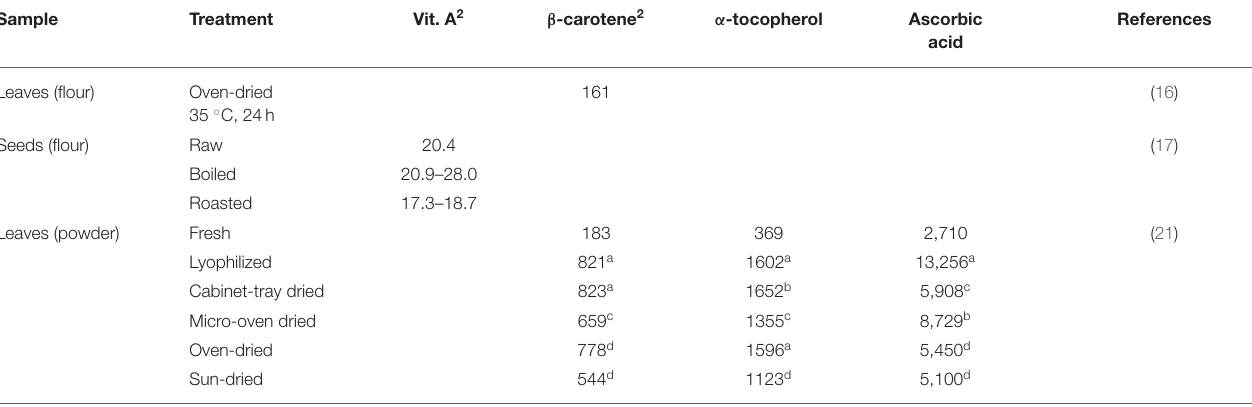
TABLE 3 | Vitamin contents in differently prepared edible parts of Moringa oleifera in µ g/g (ready to eat) 1 .